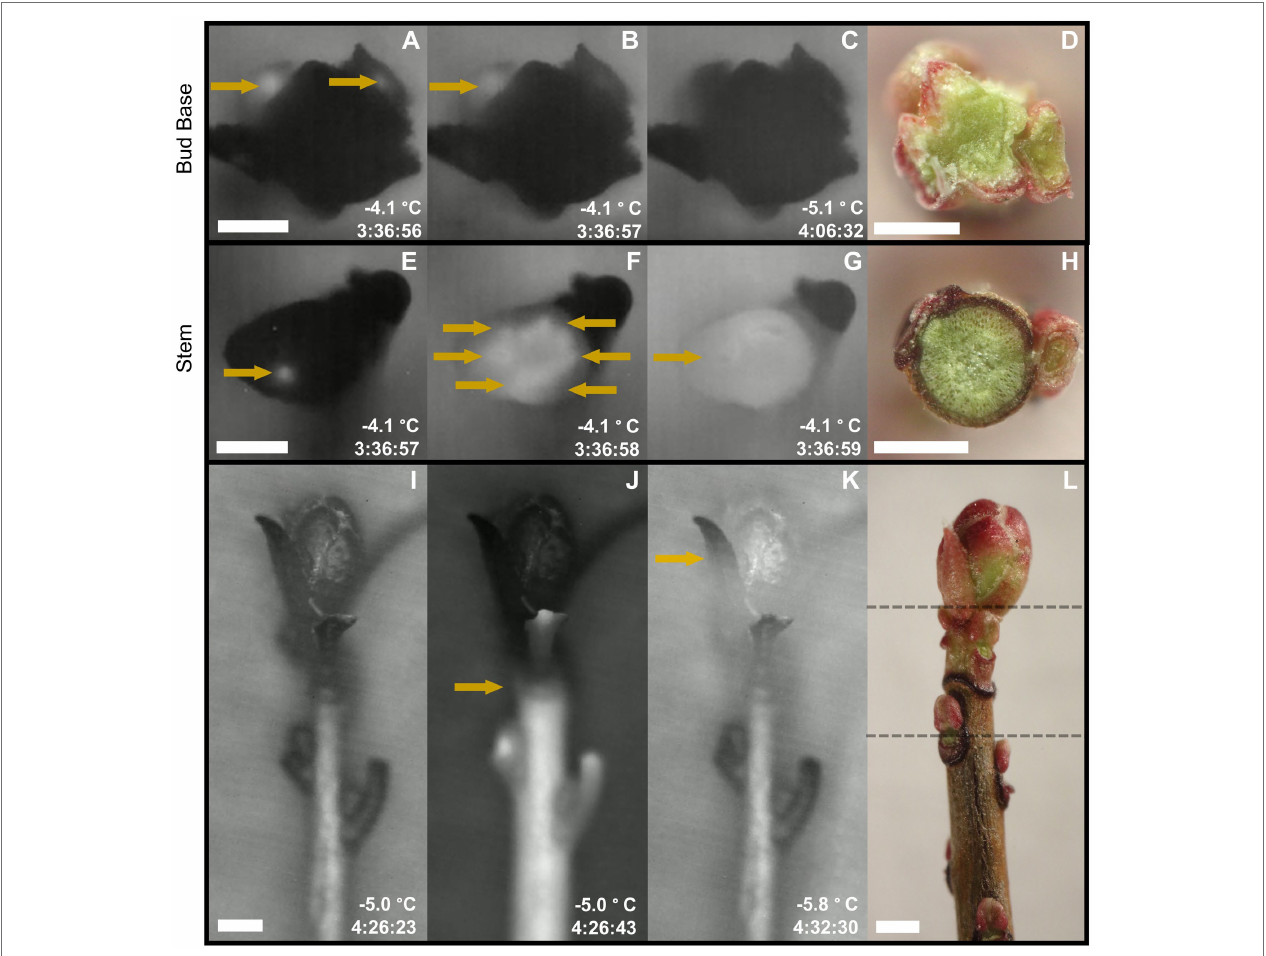
FIGURE 1 | Longitudinal and transversal high-definition thermal recordings of Vaccinium macrocarpon freezing patterns in freezing tolerant terminal buds. Time stamps represents the time elapse under the freezing treatment, only comparable under the same sampling date. Arrows highlight ice formation propagation. (A-C) Thermal images of transversal sections at the base of the bud. This sequence of images shows ice propagation from the base of the stem toward the exposed cut, where ice did not reach the surface. (D) Fresh cut of a transverse section made at the base of the bud. (E–G) Thermal images of transversal sections of the stem. This sequence of images shows ice propagation from the base of the stem toward the exposed cut, where ice reaches the surface. Ice formation reaches the surface first, most likely, through vascular tissues. (H) Fresh cut of a transversal section made at the stem zone. (I–K) Thermal images of shoots partially defoliated. This sequence of images shows ice propagation from the base of the stem toward the bud, where ice propagation stops at the base of the bud (J) . Minutes later, ice formation is initiated in the bud (K) . (L) Fresh shoot manually defoliated depicting location of bud base (upper dashed line) and stem zone (lower dashed line). Scale bar = 0.5